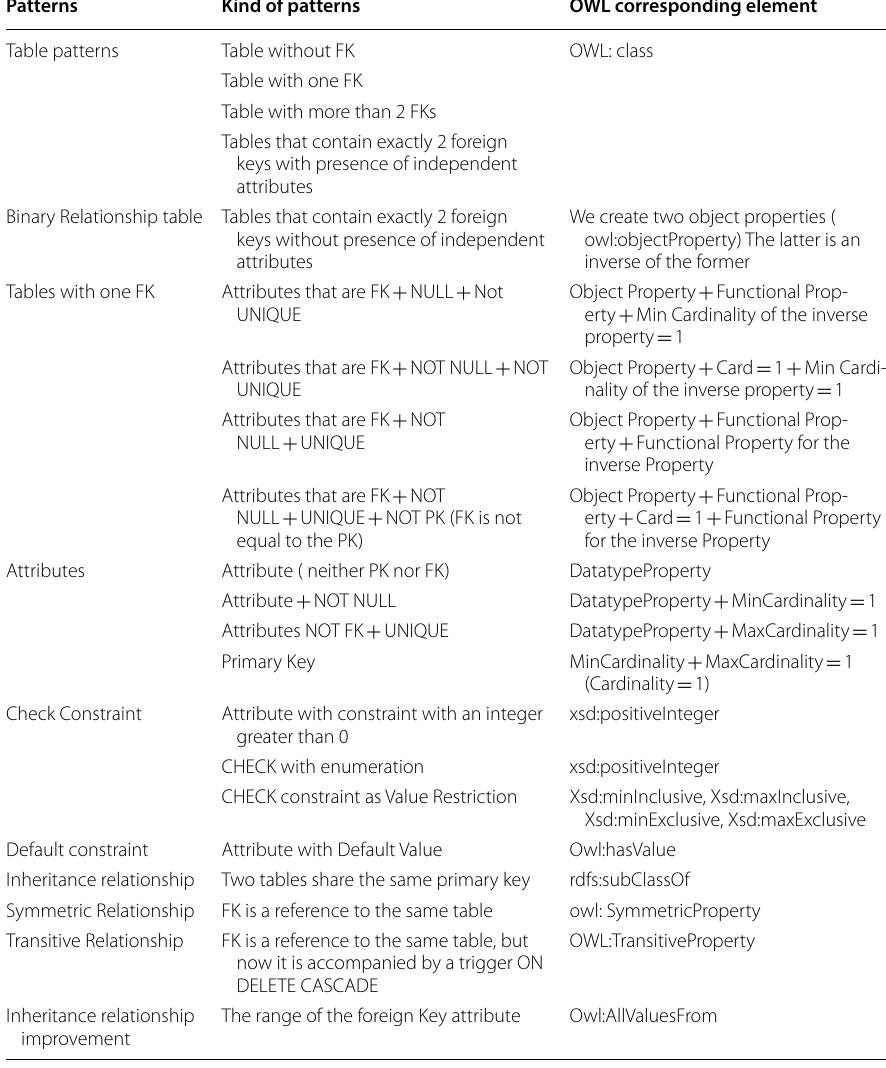
Table 2 The applied rules for generating conceptual ontology (TBox) Patterns Kind of patterns OWL corresponding element Table patterns Table without FK OWL: class Table with one FK Table with more than 2 FKs Tables that contain exactly 2 foreign keys with presence of independent